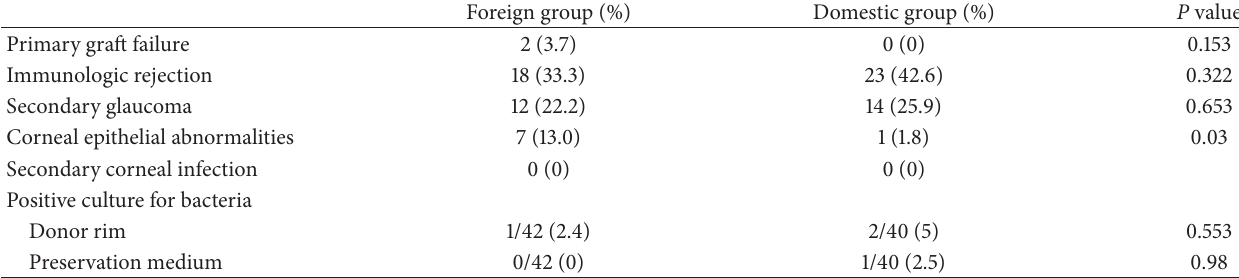
Table 7: Postoperative complications and contamination of the corneal rim and preservation medium in foreign and domestic donor